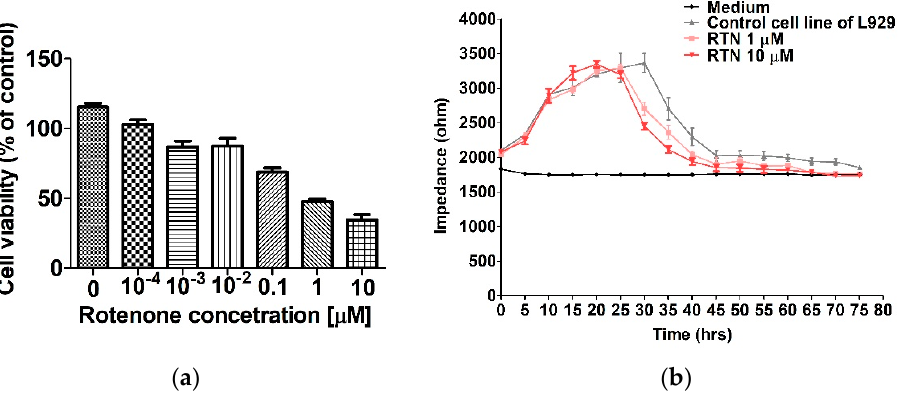
Figure 4. Influence of rotenone on the L929 cell line assessed by ( a ) the MTT assay and monitored by ( b ) the ECIS method. Data are presented as mean value ± SEM.